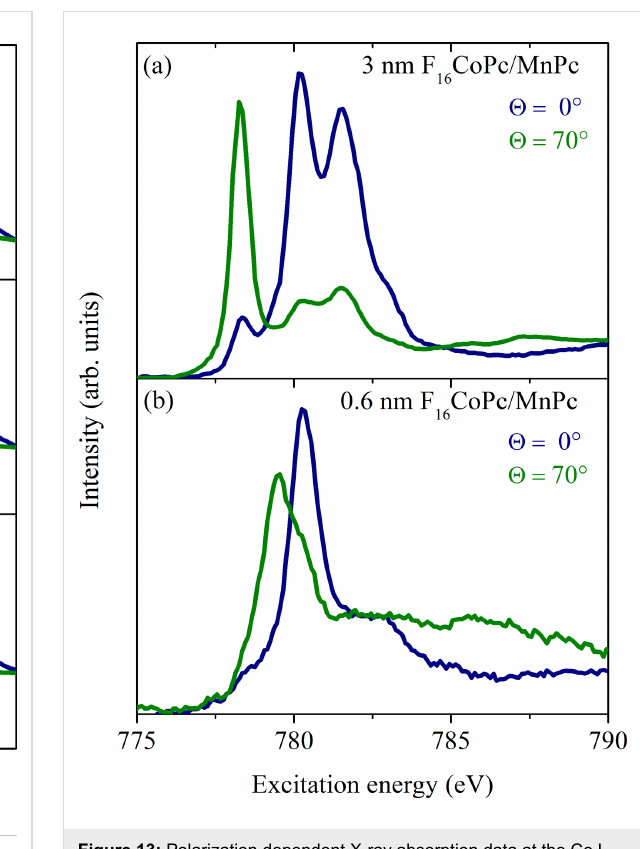
Figure 13: Polarization dependent X-ray absorption data at the Co L 3 edge for a (a) 3 nm and (b) 0.6 nm F 16 CoPc overlayer on MnPc (adapted from [127]). Again, the incident beam direction is given by the angle Θ (see Figure 12 above). The data for a 3 nm thick F 16 CoPc film on top of MnPc